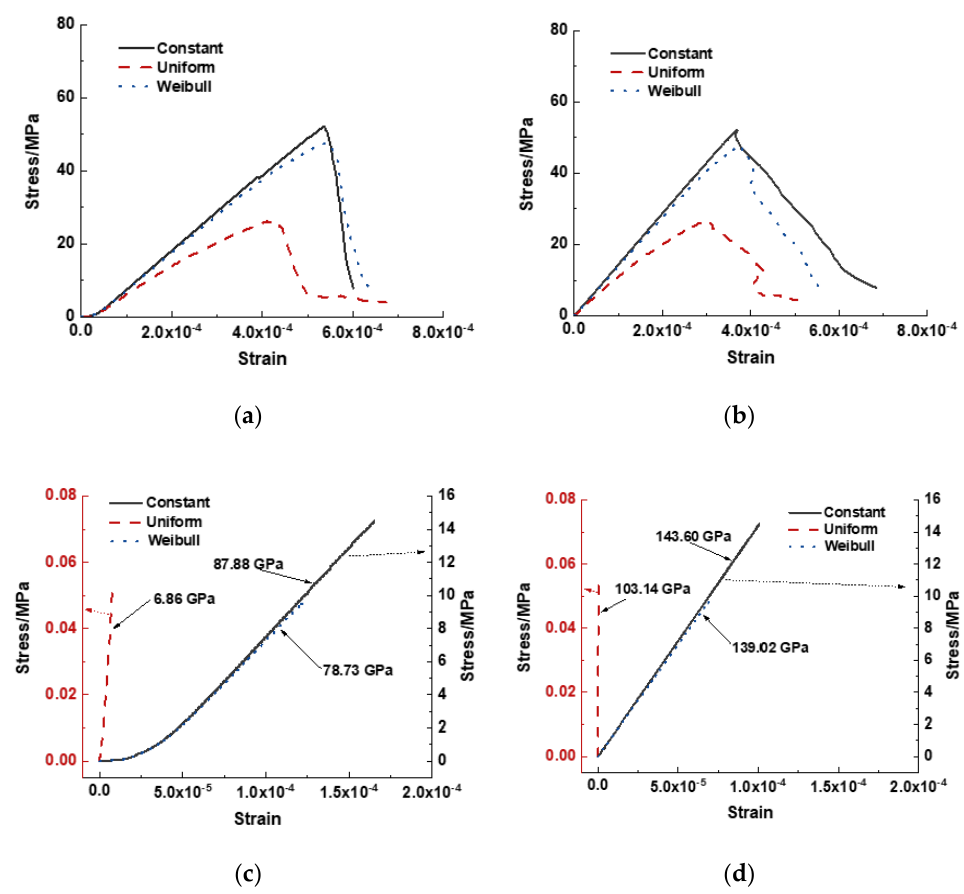
Figure 10. Stress – strain curves of cases with varying interface properties distributions. ( a ) Strain recorded from the relative displacement of loading walls; ( b ) strain recorded from gage particles; ( c ) stress – strain curve recorded from loading walls before the first crack occurs; ( d ) stress – strain curve recorded from gauge particles before the first crack occurs. Table 4. Dissipated energies determined from the stress – strain curves recorded from loading walls and gauge elements.